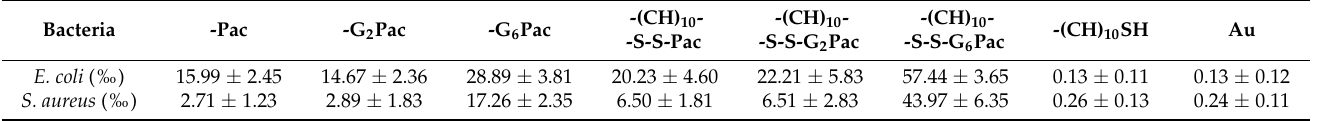
Table 4. Quantitative analysis of fluorescence images of ROS fluorescent area